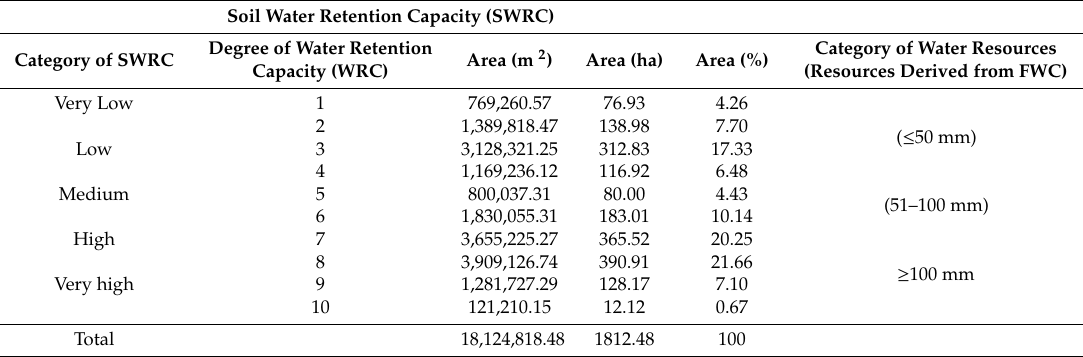
Table 5. Overview occurrence of the SWRC categories (Liptovsk á